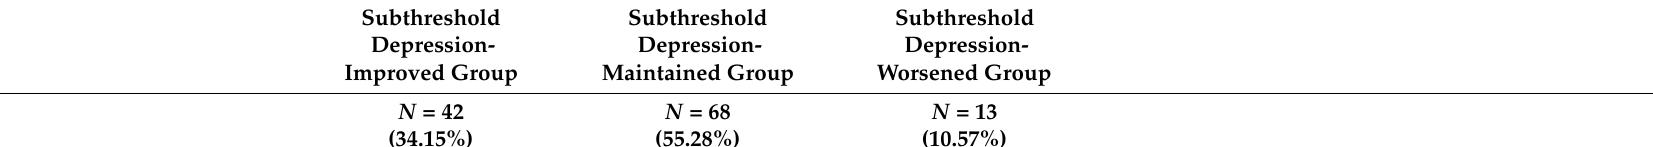
Table 2. Results of two-way repeated measures